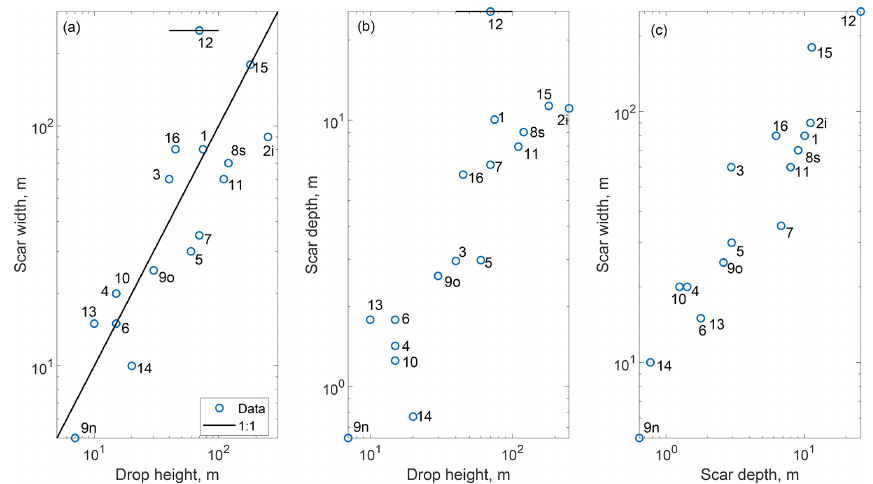
Figure 5. Correlation between the principal geometric dimensions of the surveyed landslides, drop height, scar width and scar depth. Note that scar depth is computed directly from scar width for all the landslides for which we do not have volume estimates from the field, i.e., all except LS 3, LS-4, LS-7, LS-9n, LS-10, LS-11, LS-13, LS-14 and LS-15 (see Sect.